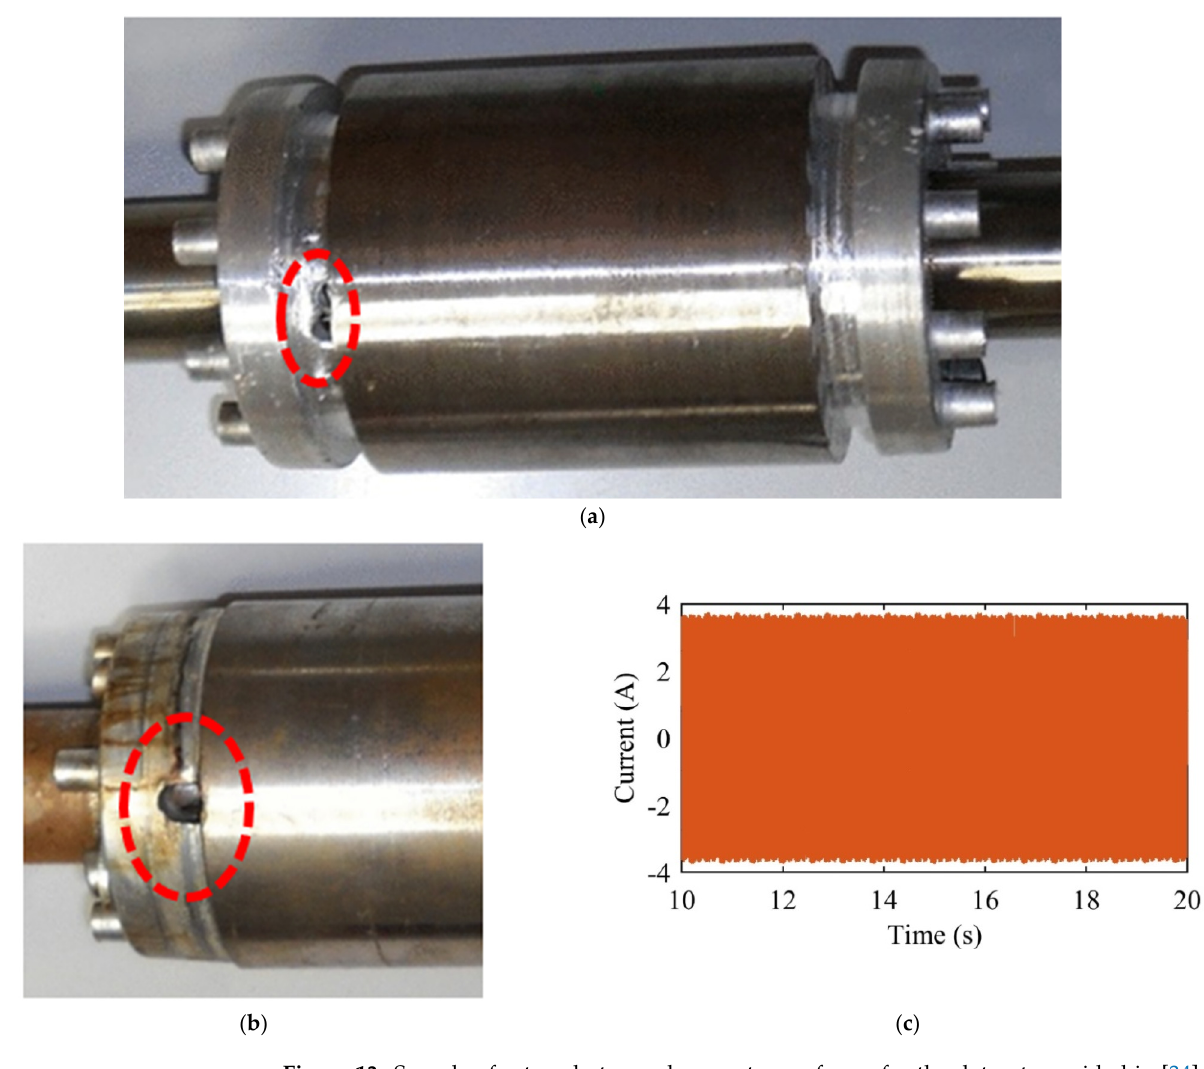
Figure 13. Sample of rotor photos and current waveforms for the dataset provided in [34]. ( a ) A photo of the rotor with two holes drilled at one bar [39]. ( b ) A photo of the rotor with one broken bar [40]. ( c ) The current waveform of one broken bar case. Table 4. Testing the proposed scheme using the experimental